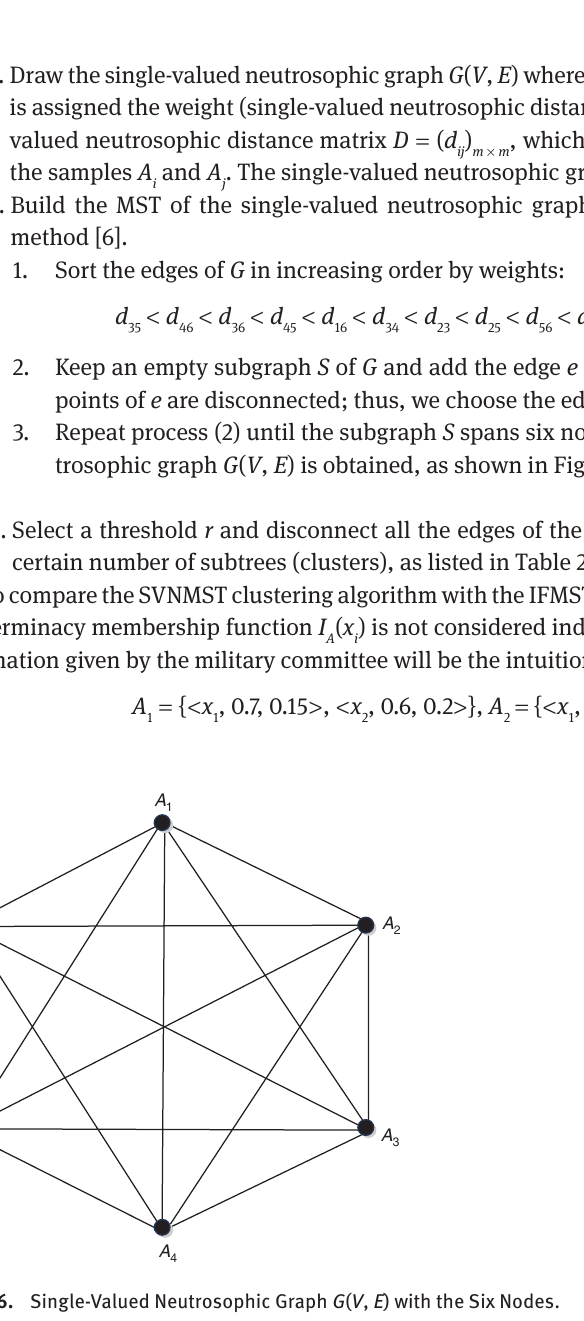
Figure 6. Single-Valued Neutrosophic Graph G ( V , E ) with the Six Nodes.